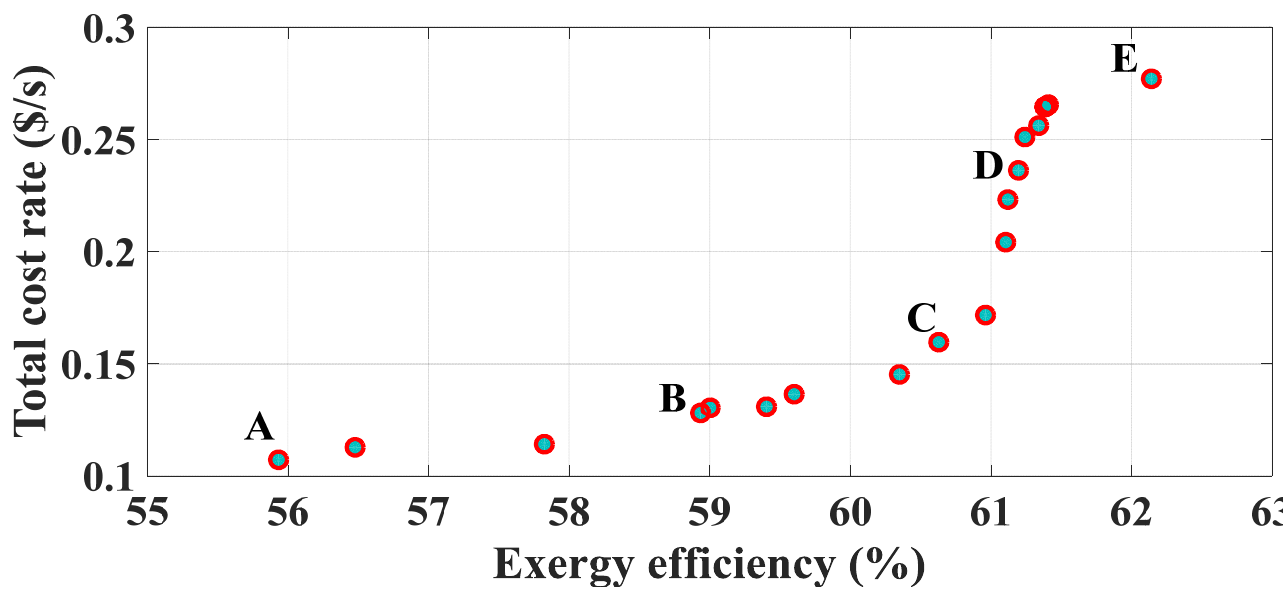
Figure 4. Pareto frontier curve. Table 11. The values of the objective functions and design variables at selected points of the Pareto curve.